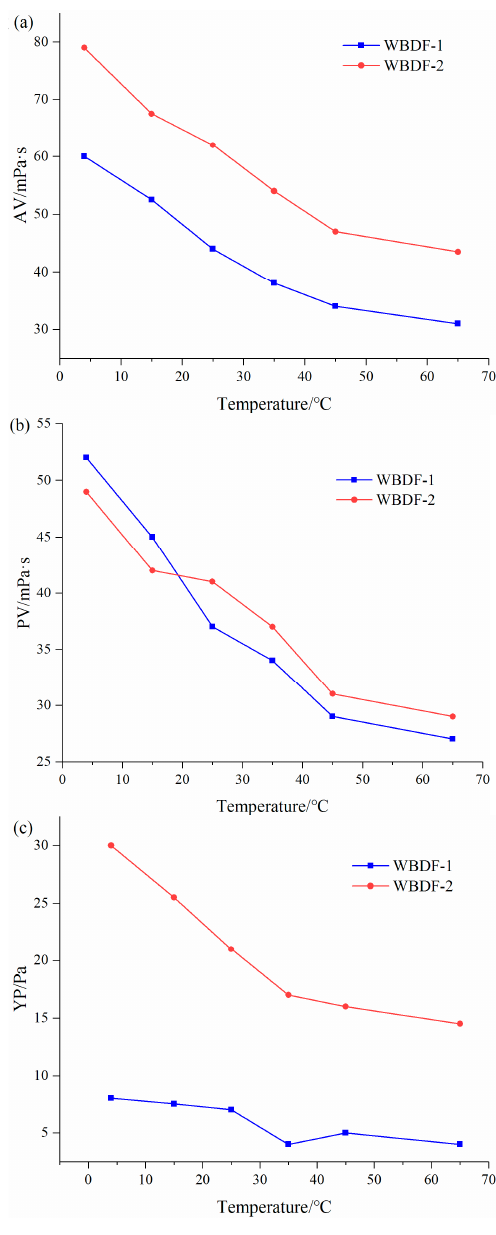
Figure 7. Effect of PNBAM on the AV ( a ), PV ( b ), and YP ( c ) performance of WBDF (water-based drilling fluids).